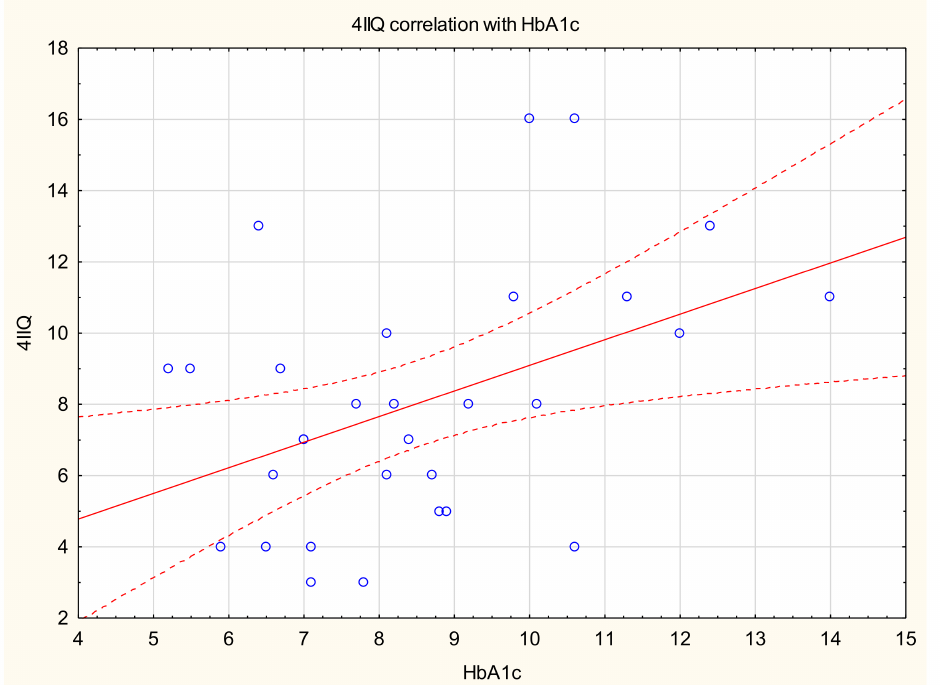
Figure 2. Spearman’s correlation analysis revealed a significant positive link between itch intensity measured with a Four-Item Itch Questionnaire (4IIQ) and glycated haemoglobin (HbA1c) values (R = 0.4, p =